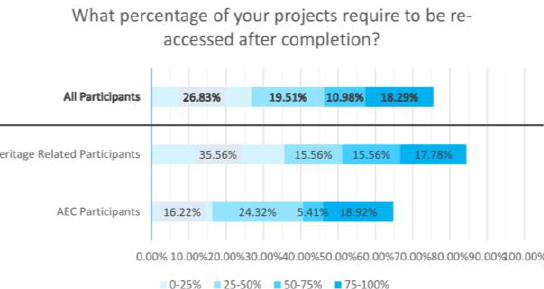
Figure 8: Percentage of projects that need future re-